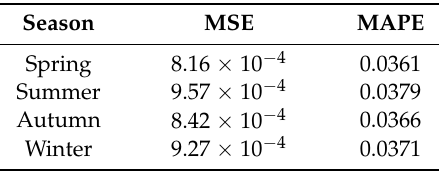
Table 3. Forecast results of different seasons by RBM-Elman